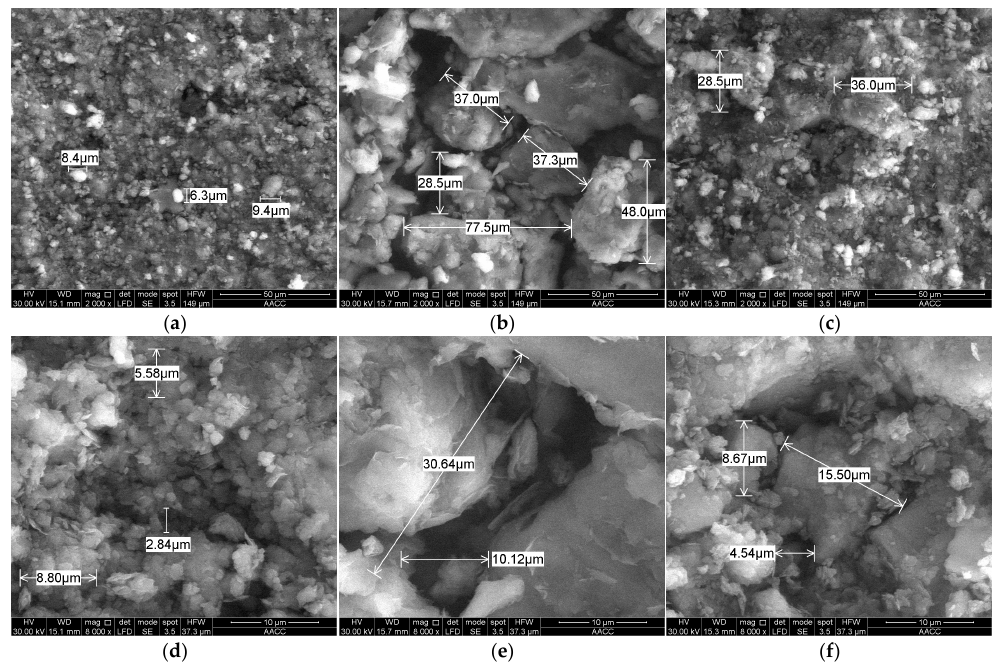
Figure 8. SEM images of microstructure of typical rock samples. ( a ) mudstone; ( b ) sandstone; ( c ) sandy mudstone; ( d ) mudstone; ( e ) sandstone; ( f ) sandy mudstone.